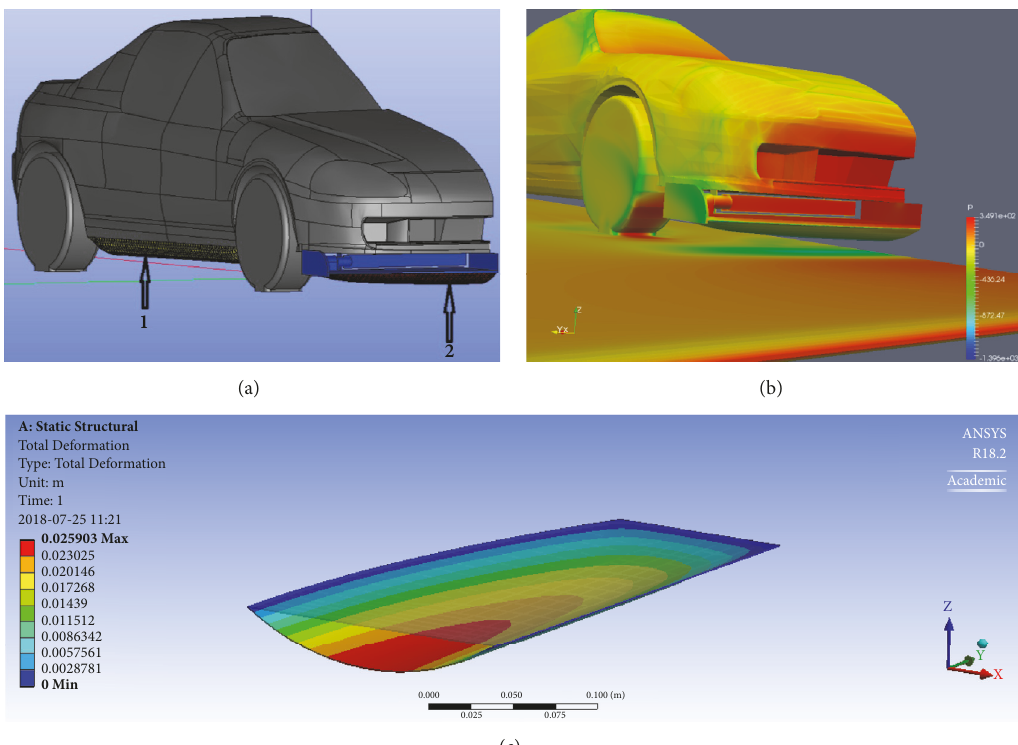
Figure 14: (a) Car with additional aerodynamic elements. The splitter is marked blue. Number 1 is a pneumatic side curtain. Number 2 is the airbag under the splitter. (b) An example of simulation results obtained using the OpenFOAM program. (c) Deformation of the airbag under the splitter. Numerical simulation carried out using the ANSYS